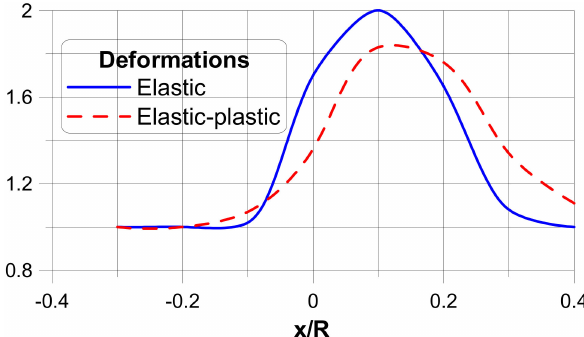
Figure 11. Distributions of the thickness reinforcement in the longitudinal